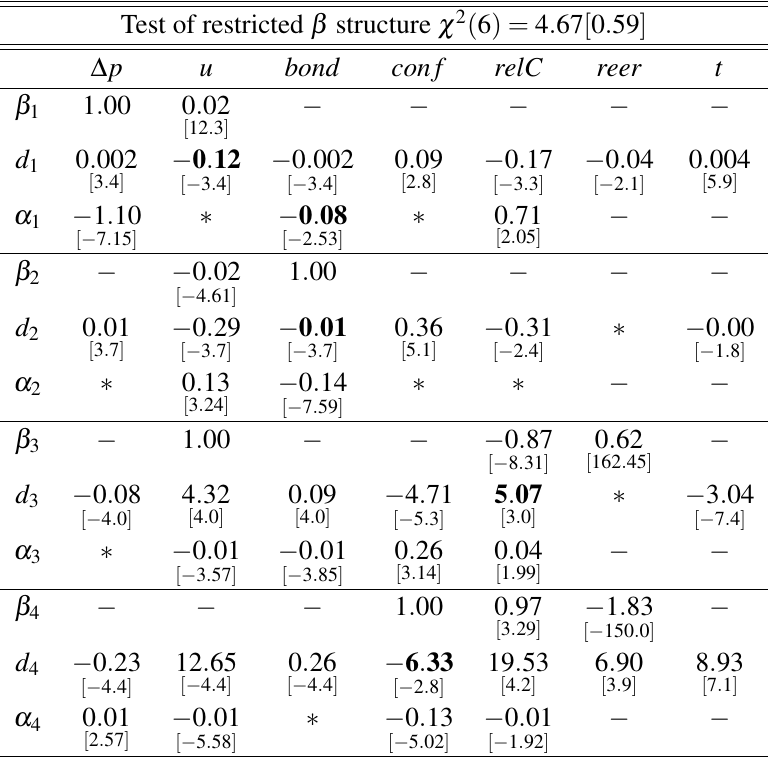
Table 3: The estimated long-run structure